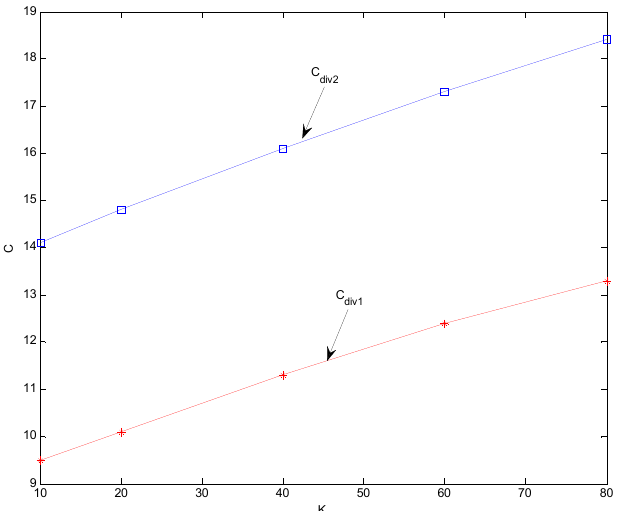
Figure 12. Effect of the small-parameter α on dimensionless complex frequencies of the axially-moving nanoplate resting on a viscoelastic foundation.